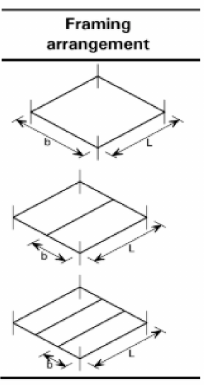
Figure 6. Framing arrangement type (SCI Design